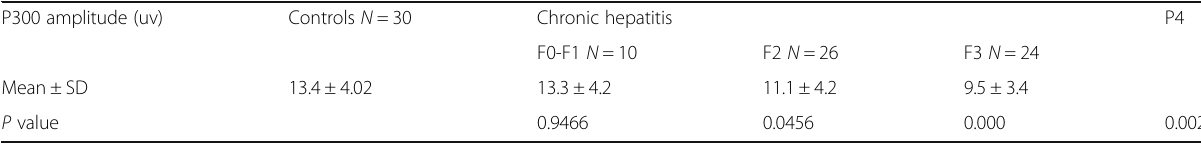
Table 6 Comparison between the studied groups regarding P300 amplitude P300 amplitude (uv) Controls N =